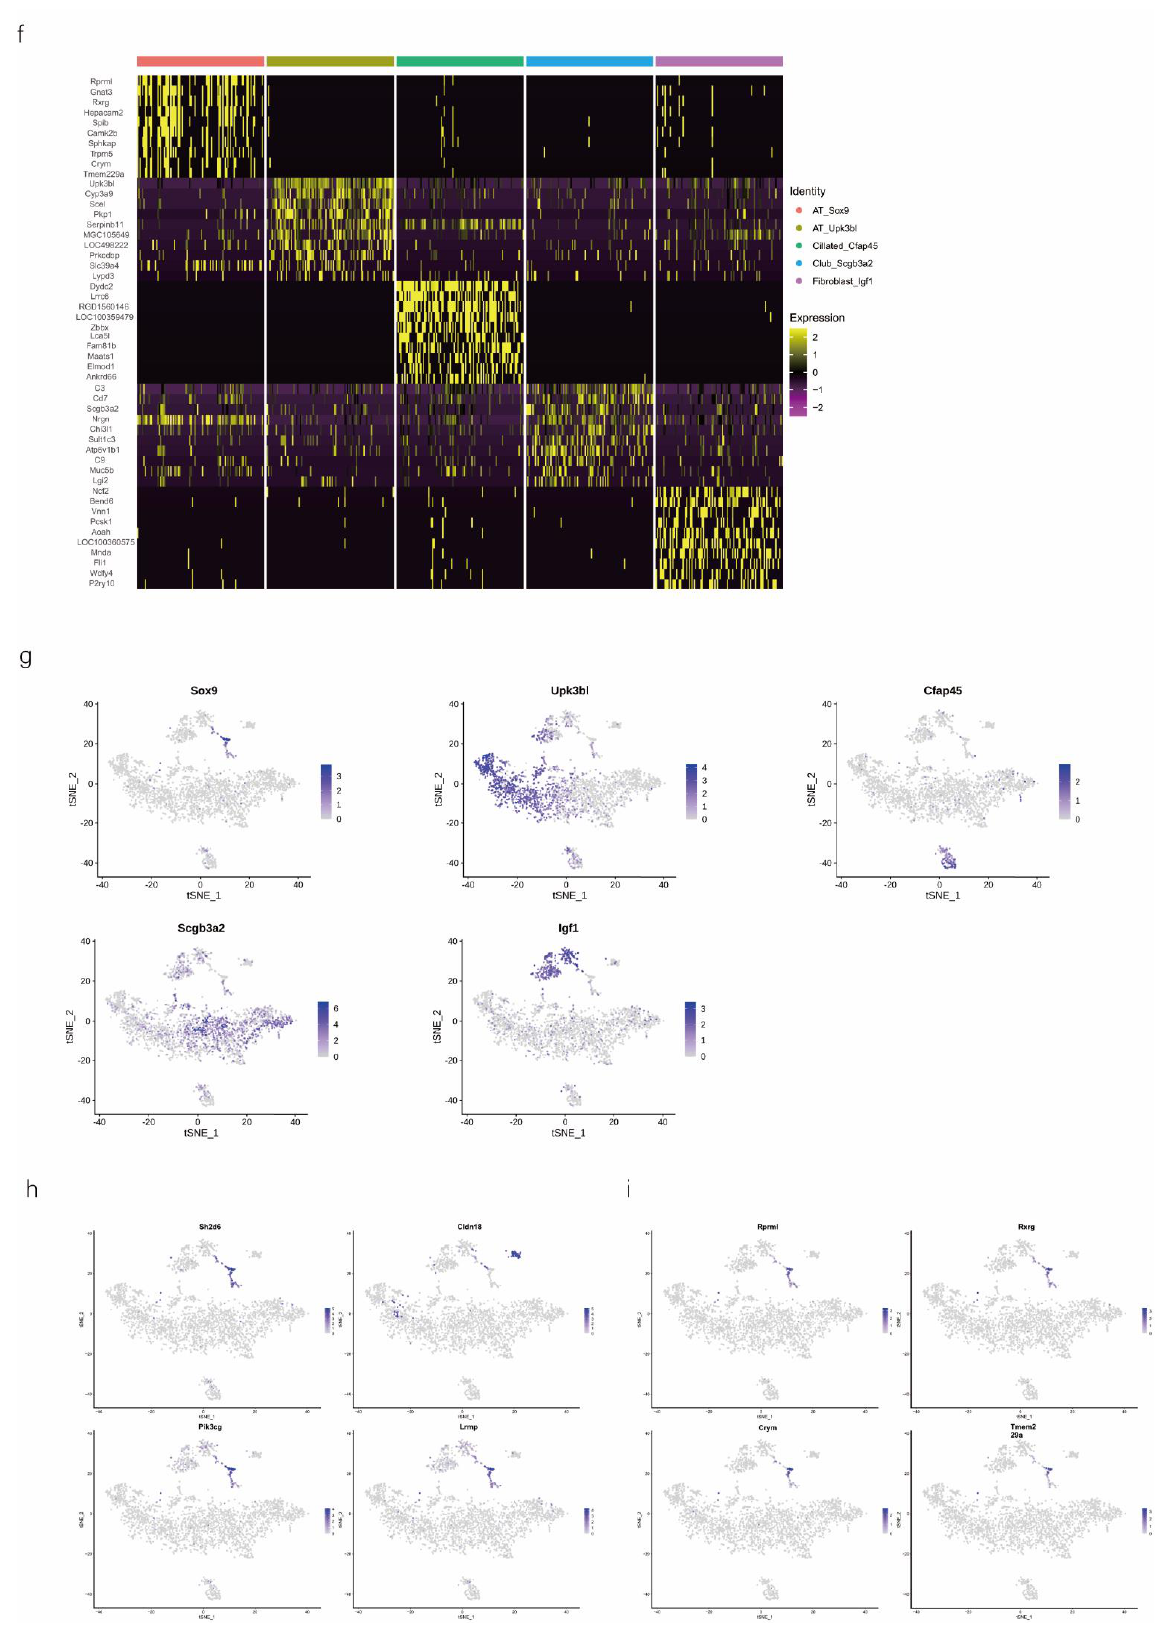
Figure 2. Identification of several types of epithelial cells by referring to the literature and the webtool CellMarker. ( a ) tSNE plots of the cell-type distribution of all identified epithelial cells, including